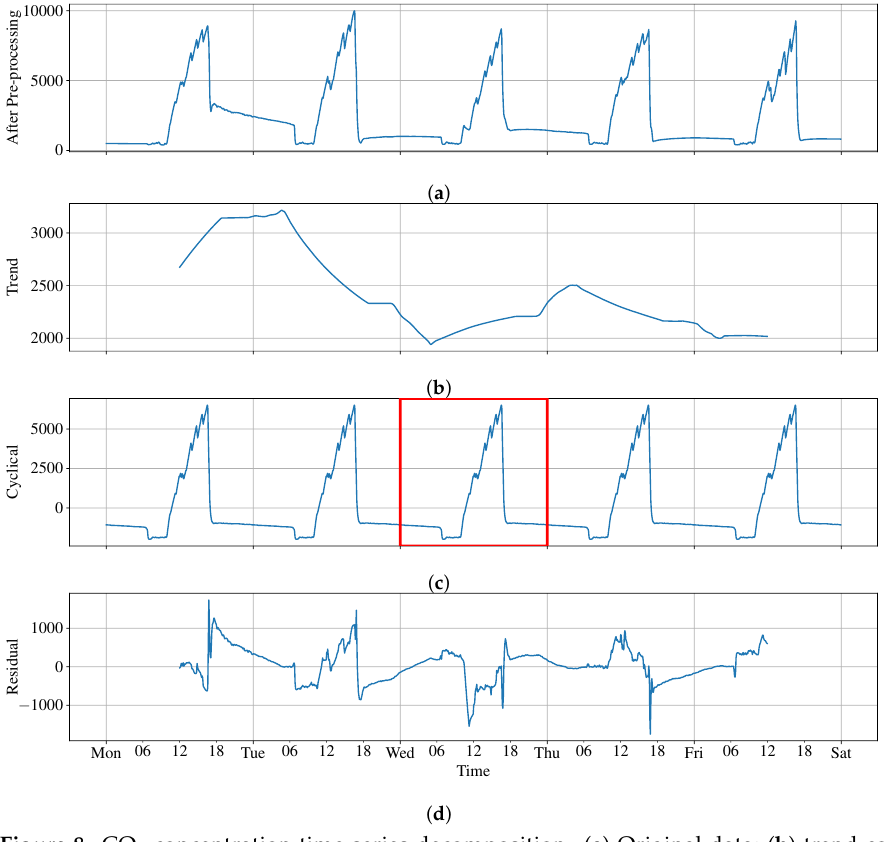
Figure 8. CO 2 concentration time series decomposition. ( a ) Original data; ( b ) trend component; ( c ) cyclical component; ( d ) residual component. In Figure 9, the red dashed line is the fluctuation after preprocessing and the solid blue line is the cyclical component after time series decomposition. The value of cyclical compo- nents is not the same as the original one. However, the fluctuation is highly correlated with the original trend.